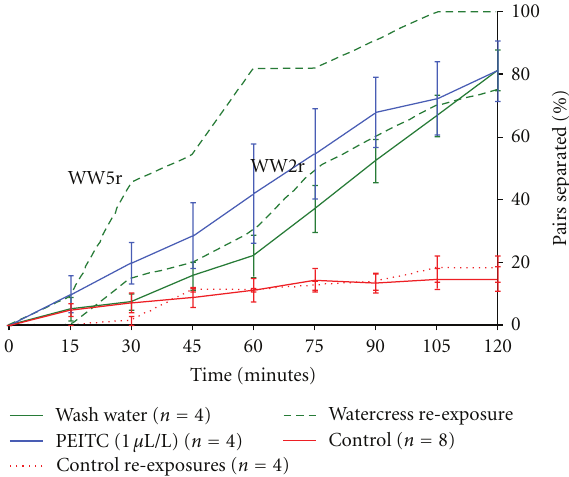
Figure 2: Cumulative proportion of pairs separated-watercress wash water re-exposures. Solid lines show the mean response for four separate initial exposures. The initial wash water exposure (green) is emboldened for comparison with re-exposures (green- dotted lines) to wash water on 2 separate test occasions; Test WW5r (11 pairs) after exposed test organismshad spent 24h in clean water, and Test WW2r (20 pairs) after exposed test organisms had spent 48h in clean water. The mean response of 4 control re-exposures (red) follows a similar pattern to the initial control exposure (red- dotted line shows the mean of 8 control exposures). Vertical bars show standard error; n denotes the number of